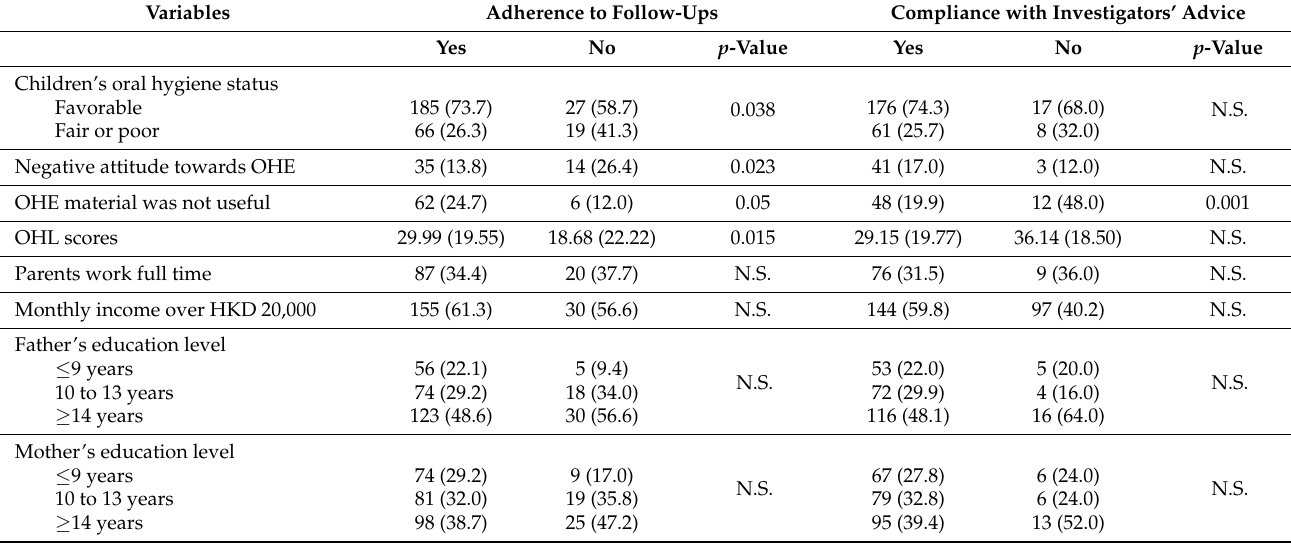
Table 2. Parental compliance among parents with various OHL, attitudes, perception of children’ oral hygiene status, and SES.